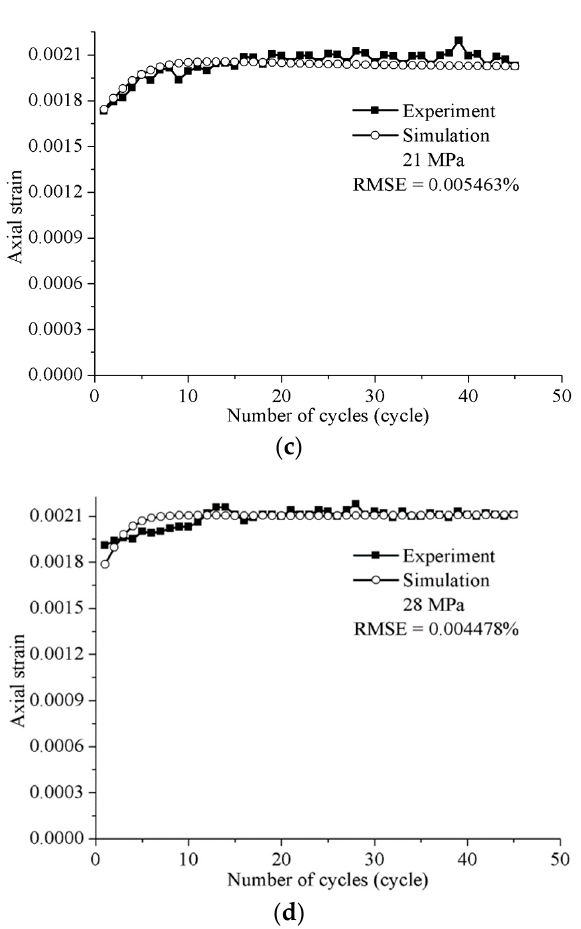
Figure 4. Comparison of the maximum axial strain from the numerical simulation and experiment under different internal pressures: ( a ) 0 MPa, ( b ) 10 MPa, ( c ) 21 MPa, and ( d ) 28MPa.